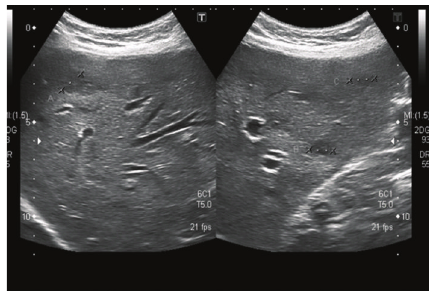
Figure 6: Ulceration progressing to central necrosis.